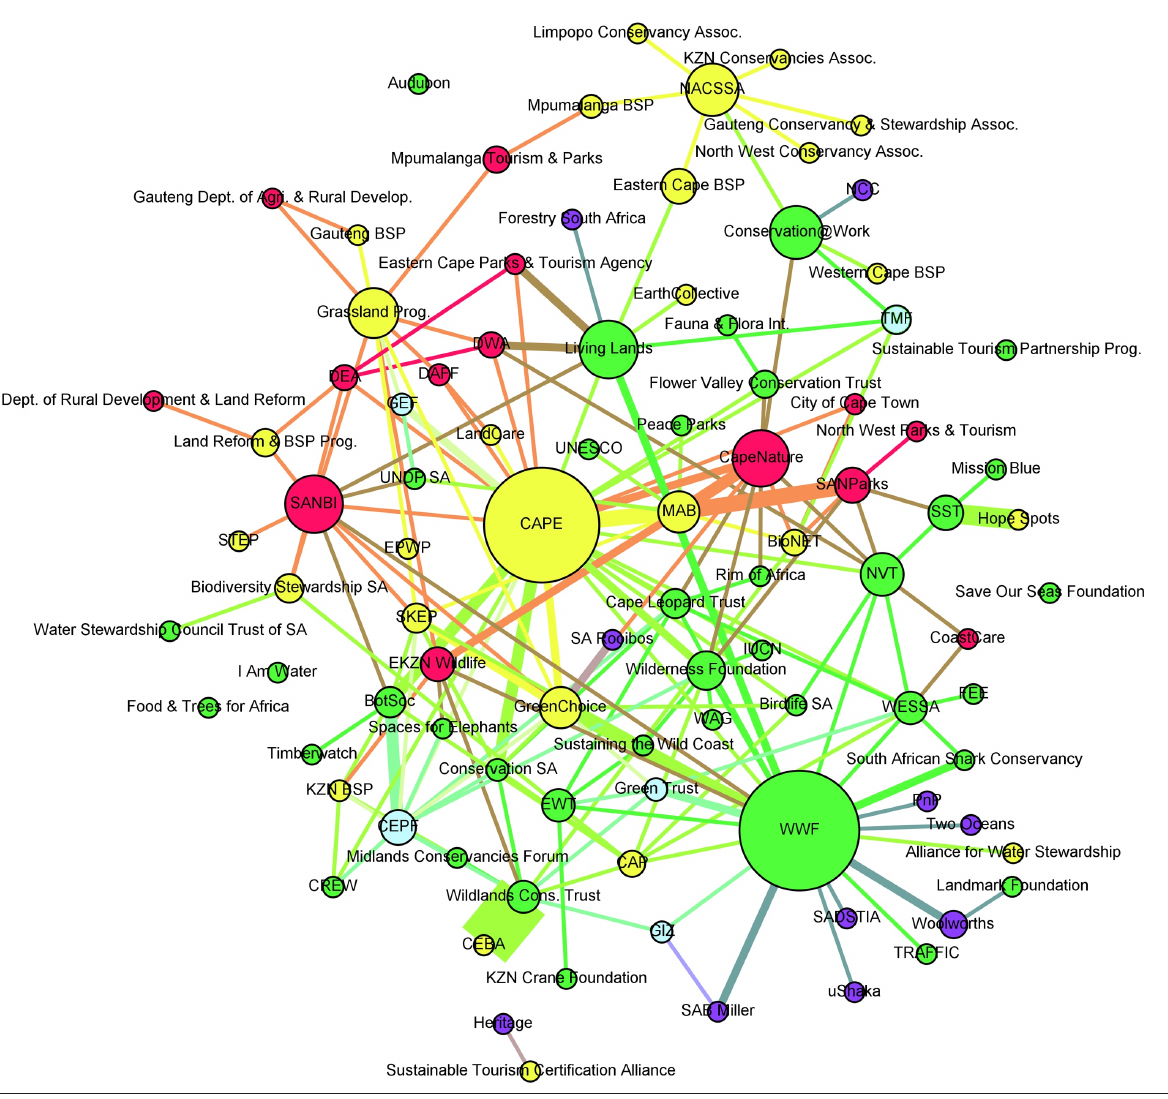
Note: green = non-governmental oganisations; yellow = partnerships; red = government entities; blue = funds; lilac = private entities Figure 1: Main actors involved in conservation and sustainability stewardship schemes in South Africa as a social network with 94 nodes and 180 edges (visualised in Gephi 0.8.2 beta). The thickness of links is relative to the number of collaborations and associations between nodes. The nodes are sized on an arbitrary scale (5–50) relative to their betweenness centrality as an indicator of relative prominence or involvement within the network. (See Appendix for full labels and